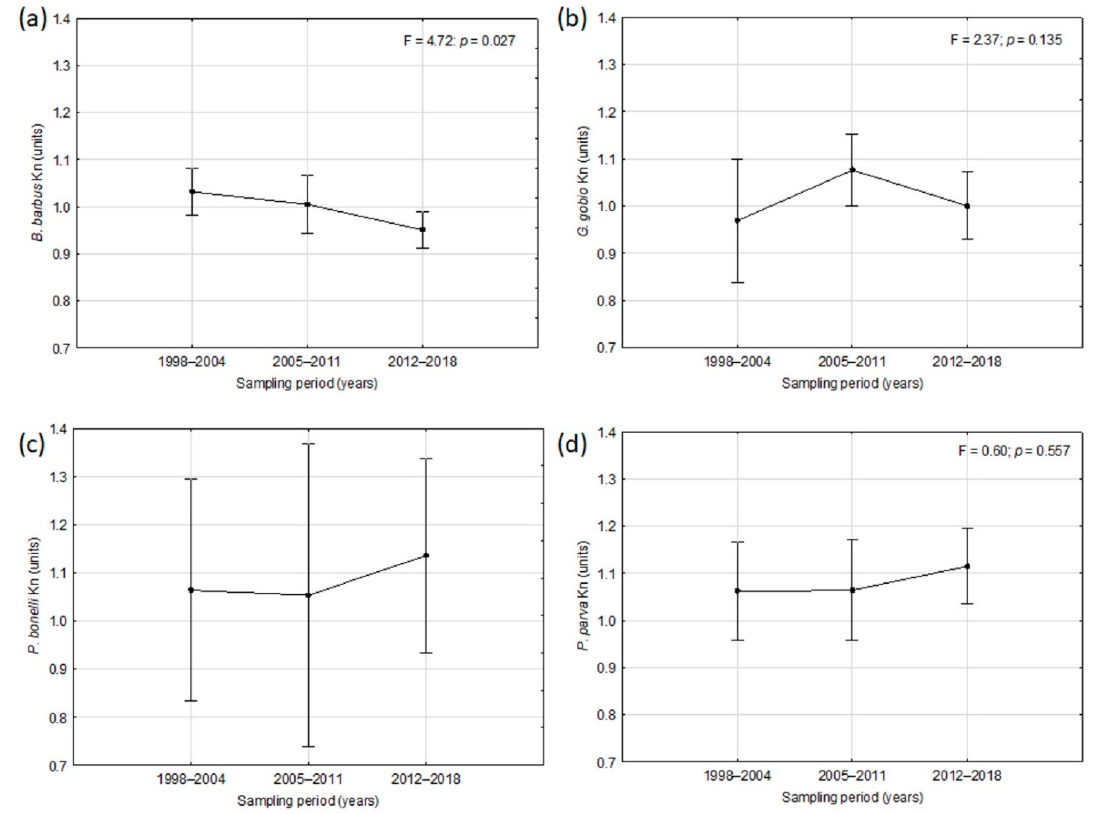
Figure 6. Trend over time of the mean condition factor (Kn) values for: ( a ) Barbus barbus , ( b ) Gobio gobio , ( c ) Padogobius bonelli , ( d ) Pseudorasbora parva . Vertical bars denote 0.95 confidence intervals.